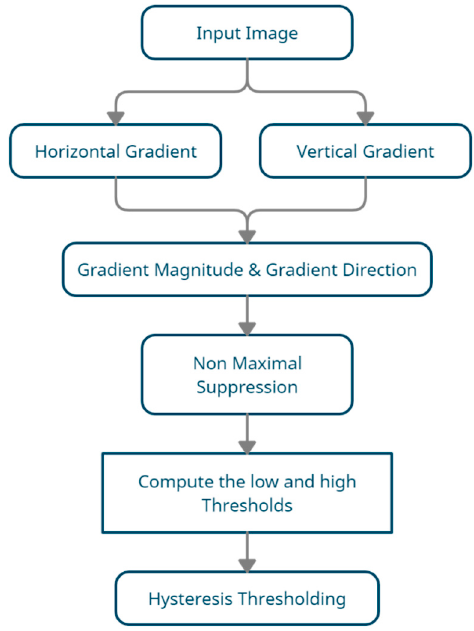
Figure 10. Steps involved in Canny Edge Detection.